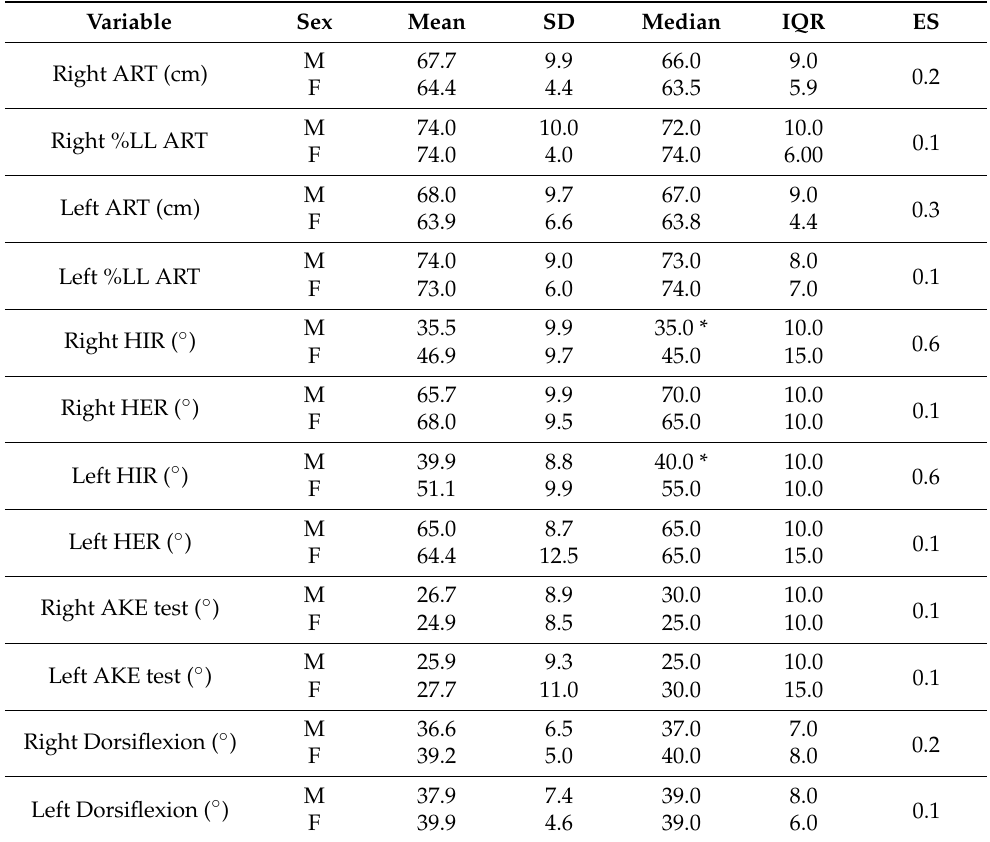
Table 2. Balance and range-of-motion